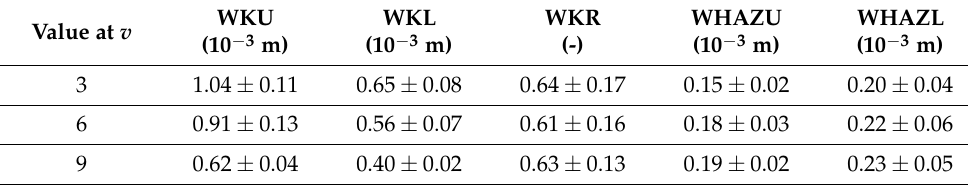
Table 2. Descriptive statistics of all the measured parameters vs. v